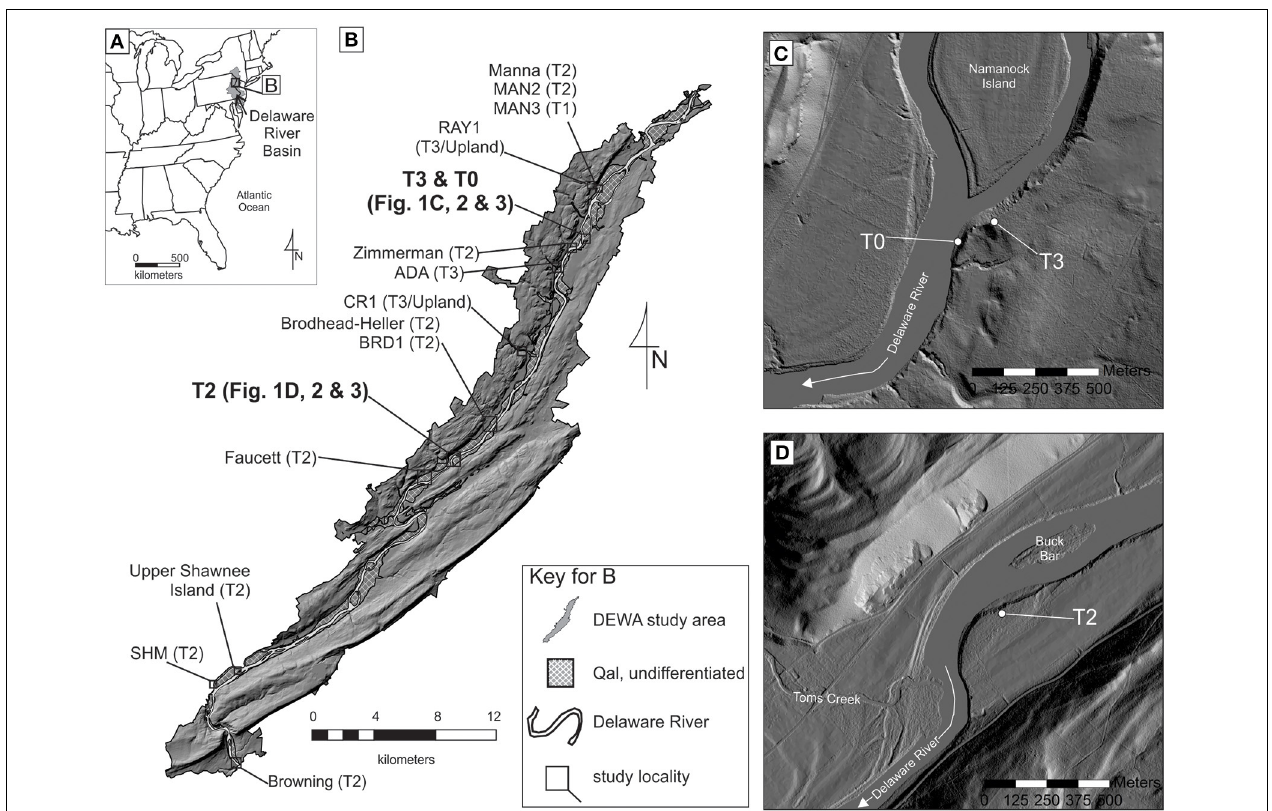
FIGURE 1 | Study area. (A) Inset map of eastern North America showing the Delaware River Basin (gray) (modified from Stinchcomb et al., 2013). (B) The Delaware Water Gap National Recreation Area showing profile locations (T3, T2, and T0) mentioned in text (modified from Stinchcomb et al., 2012). The environmental magnetic properties of these three profiles were examined in